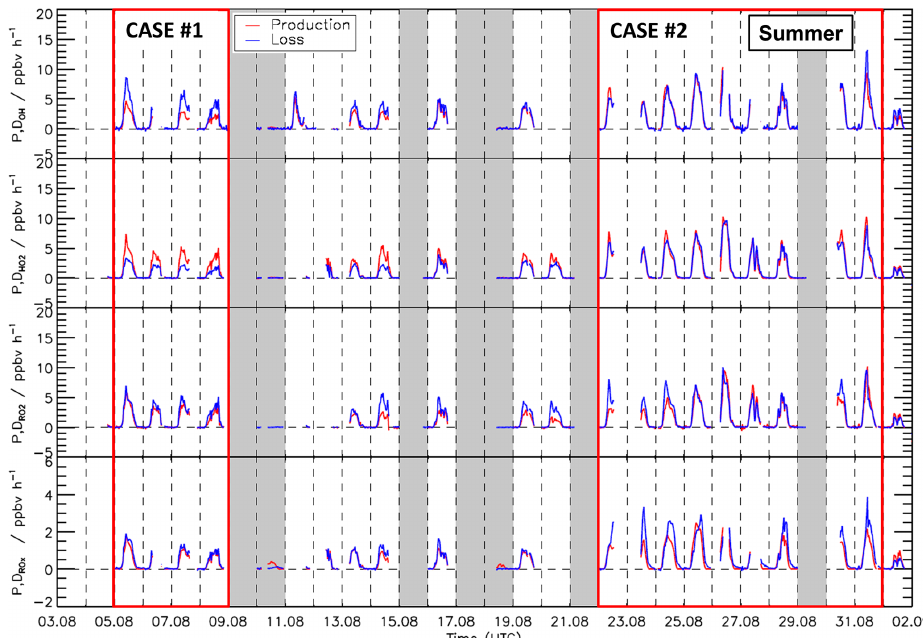
Figure 7. Time series of total production and destruction rates of OH, HO 2 , RO 2 , and RO X radicals in the summer period of the JULIAC campaign. Vertical dashed lines denote midnight. Grey areas indicate calibration days and days when the chamber roof was closed. The red boxes denote periods that are discussed in more detail (Case 1 and Case